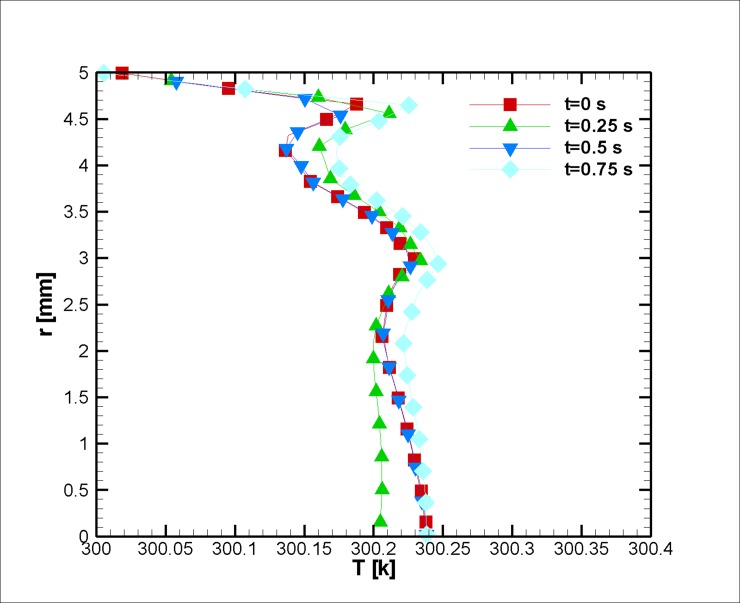
Velocity in the axial direction at z = 4 cm for the case of Joule heating, Lvessel = 7 cm, Rvessel = 1 cm and fifty percent stenosis.